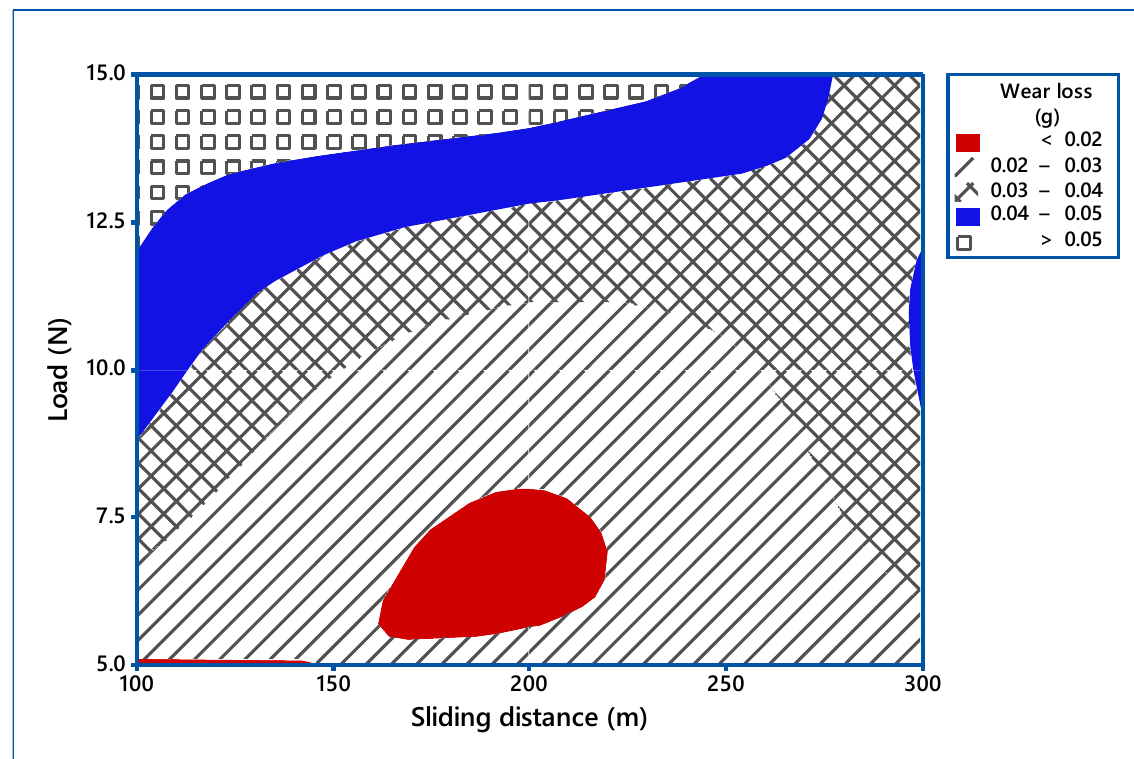
Figure 7. Contour plot for wear loss (Load vs. sliding distance).